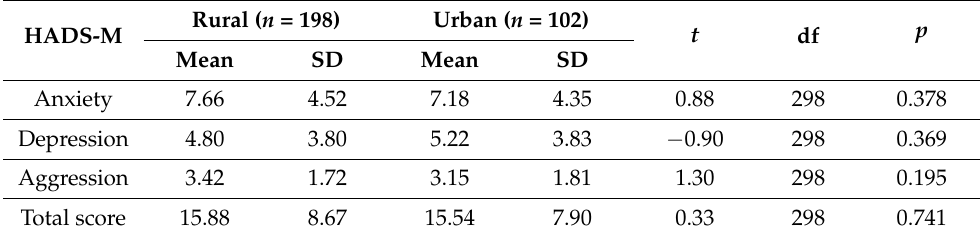
Table 3. HADS-M scores with regard to place of residence.